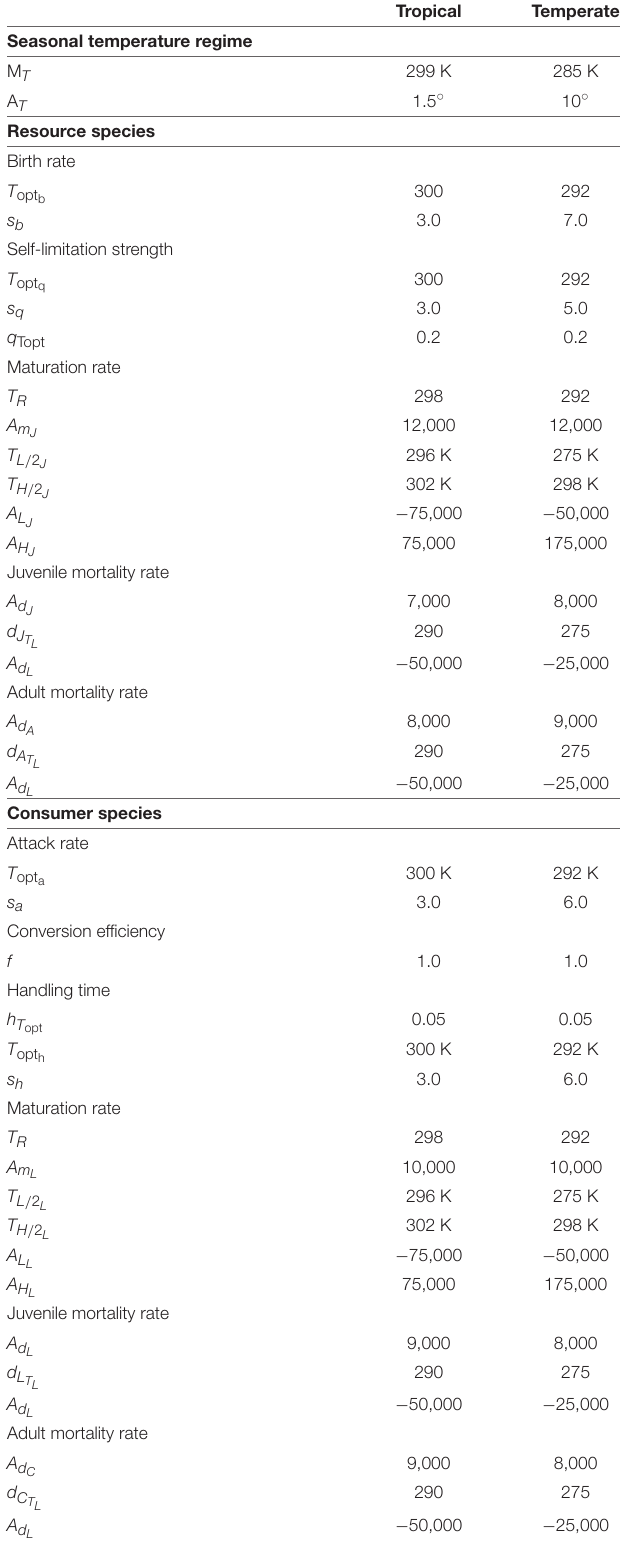
temperature increases faster than the minimum TABLE 1 | Temperature response parameters for tropical and temperate species. Tropical Temperate